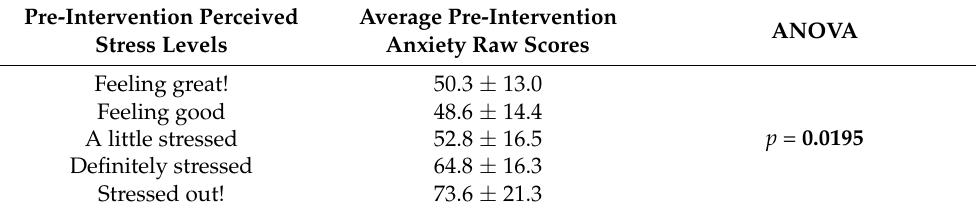
Table 5. Association between Pre-Intervention Anxiety and Stress.